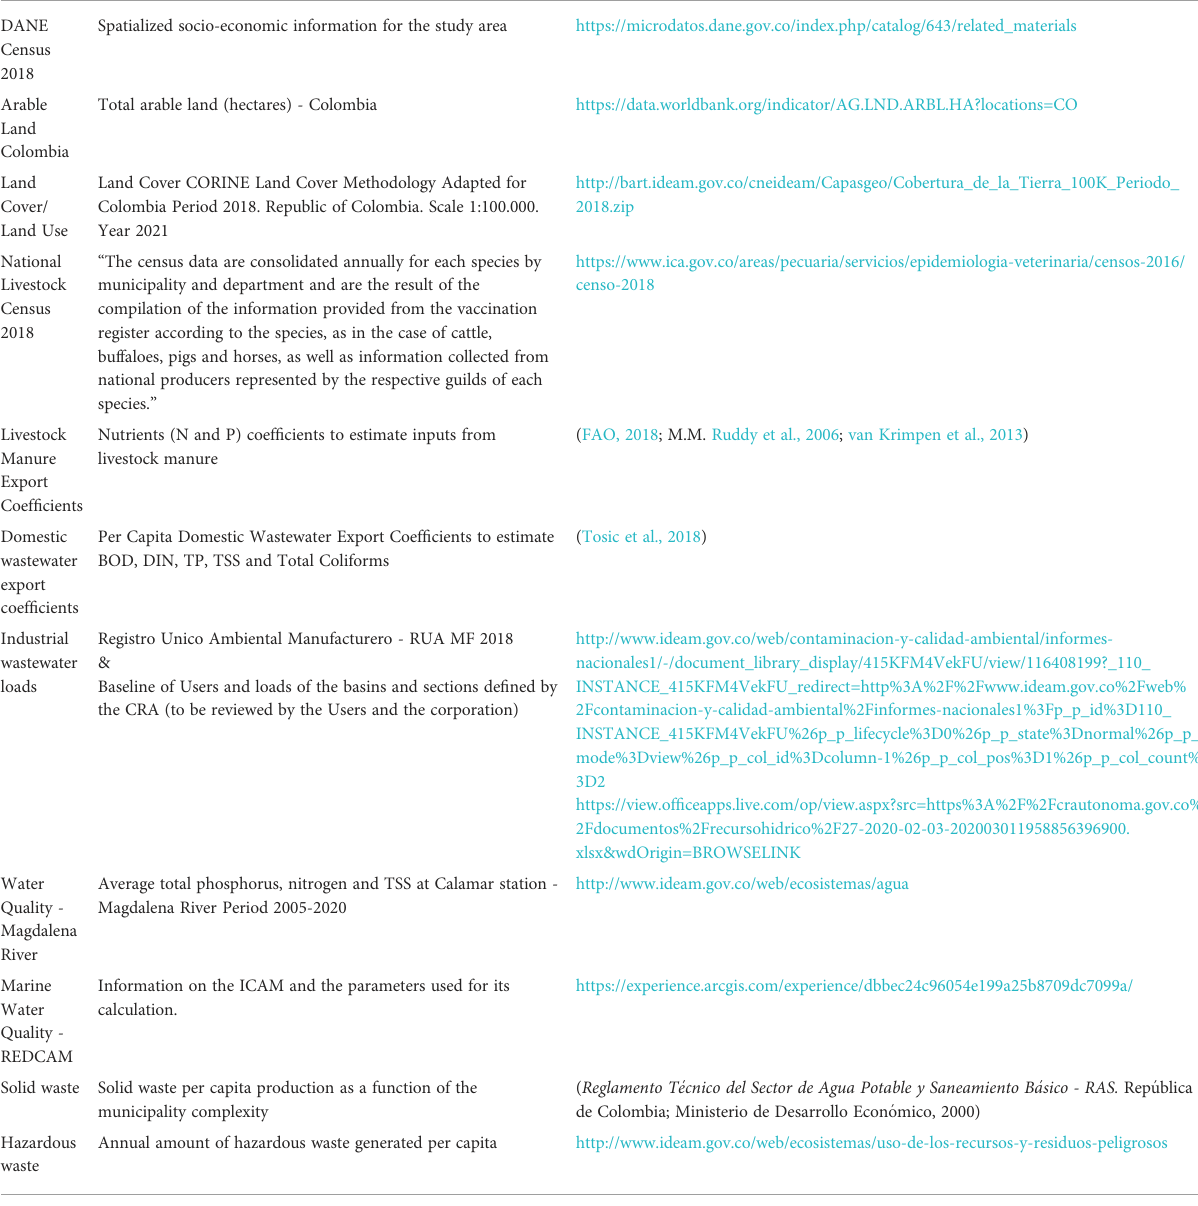
TABLE 1 Summary of information